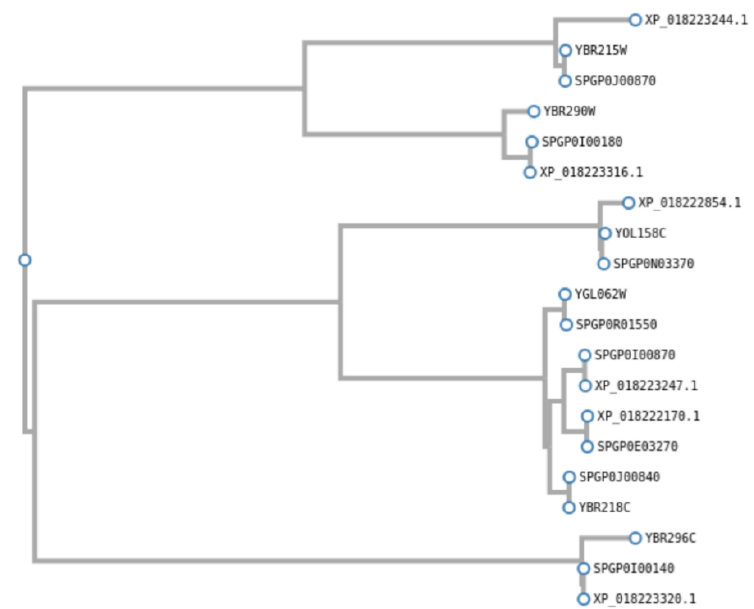
Figure 8. Phylogenetic tree of S. pastorianus WS34/70 genes with their homologs in S. cerevisiae S288C and S. eubayanus FM1318. Table 3. HybridMine parental allele prediction output for eight S. pastorianus WS 34/70 genes and parental allele phylogenetic tree output.